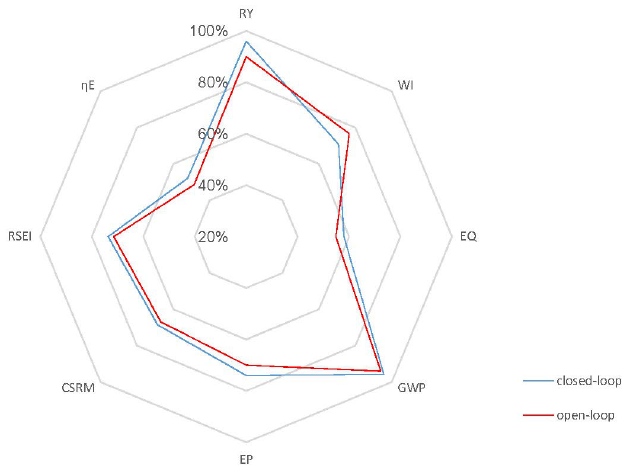
Figure 9. Radar plot with GREENSCOPE indicators for the closed-loop and open-loop simulations (Case 2). (Case 2).